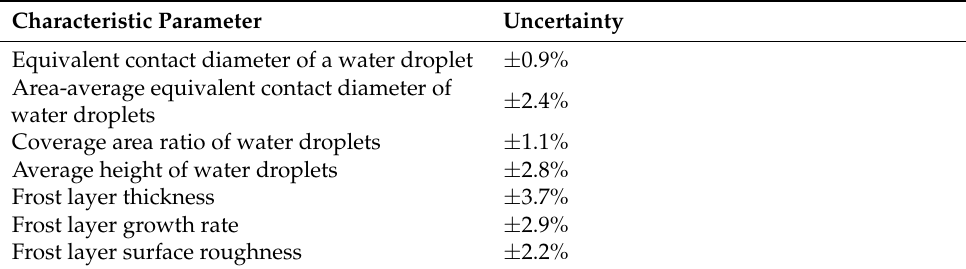
Table 2. Uncertainties of the characteristic